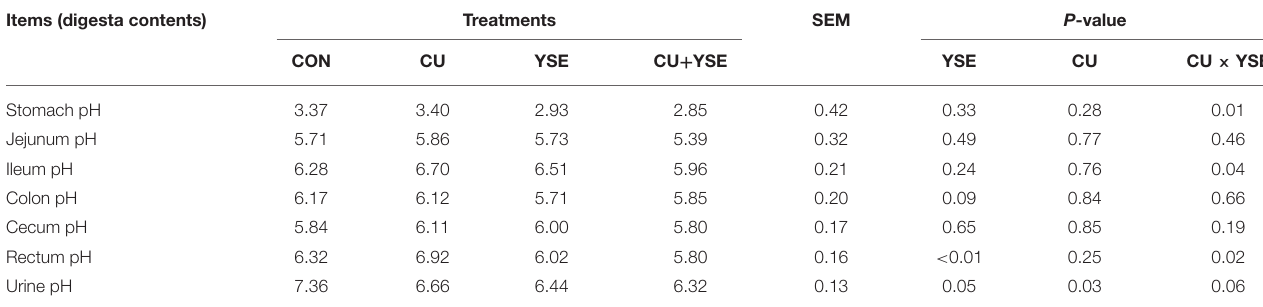
TABLE 4 | Effects of dietary YSE and oral CU on gastrointestinal tract pH in weaned